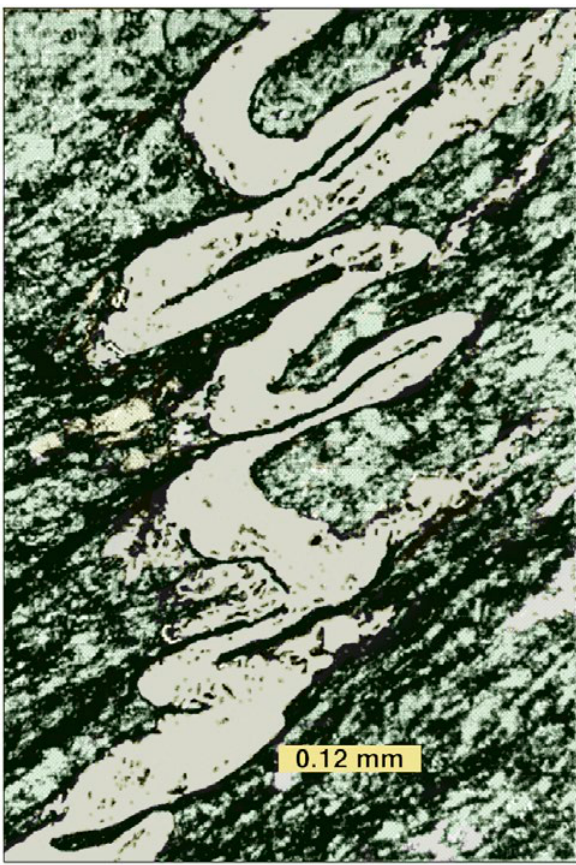
Figure 77. During diagenesis the highly fluid pale green chlorite content of the Conasauga shales was able to flow under a small dif- ferential pressure into a ptygmatic veinlet as illustrated by Weaver (1984, fig. 38). Chlorite in the veinlet, possibly only a little 'cleaner', is the same as that in the fabric of the diagenetic mud from which it merges and oozes out into the vein from a series of interlayer off- shoots.